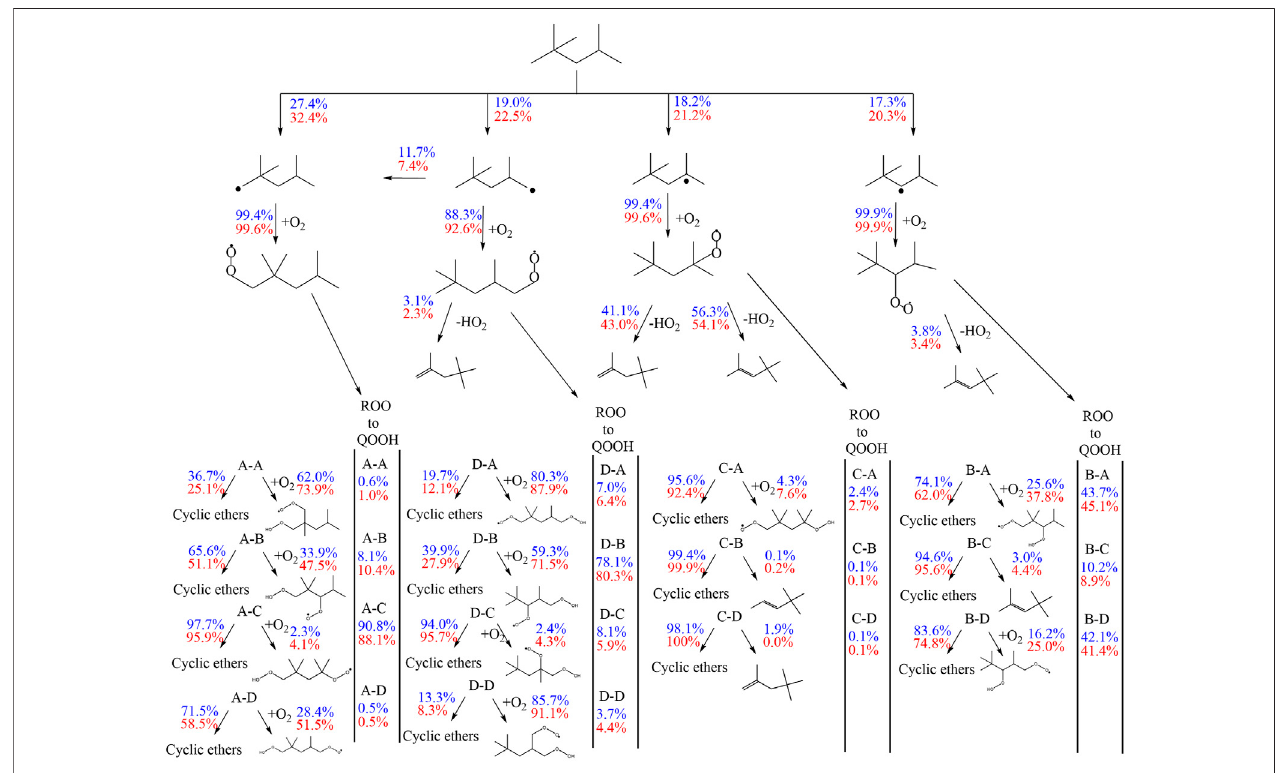
FIGURE 11 | Flux analysis performed with the model of Atef et al. (2017) at 10 (blue) and 20 bar (red), 623 K at 25% of the maximum achieved conversion of iso-octane at the speci fi c condition.